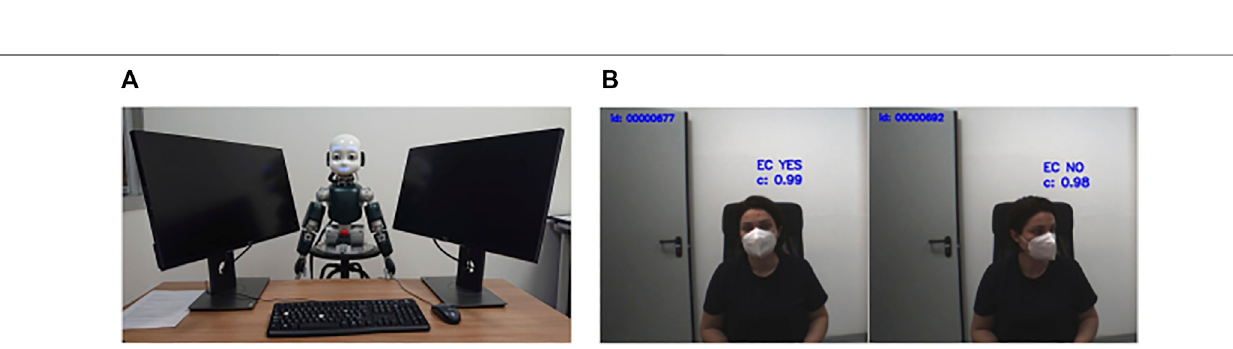
Frontiers in Robotics and AI |